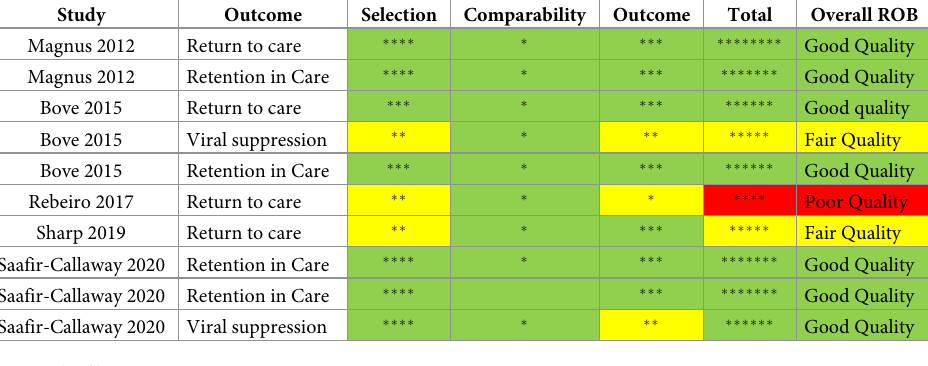
Table 4. Risk of biases in the included cohort studies that had a control